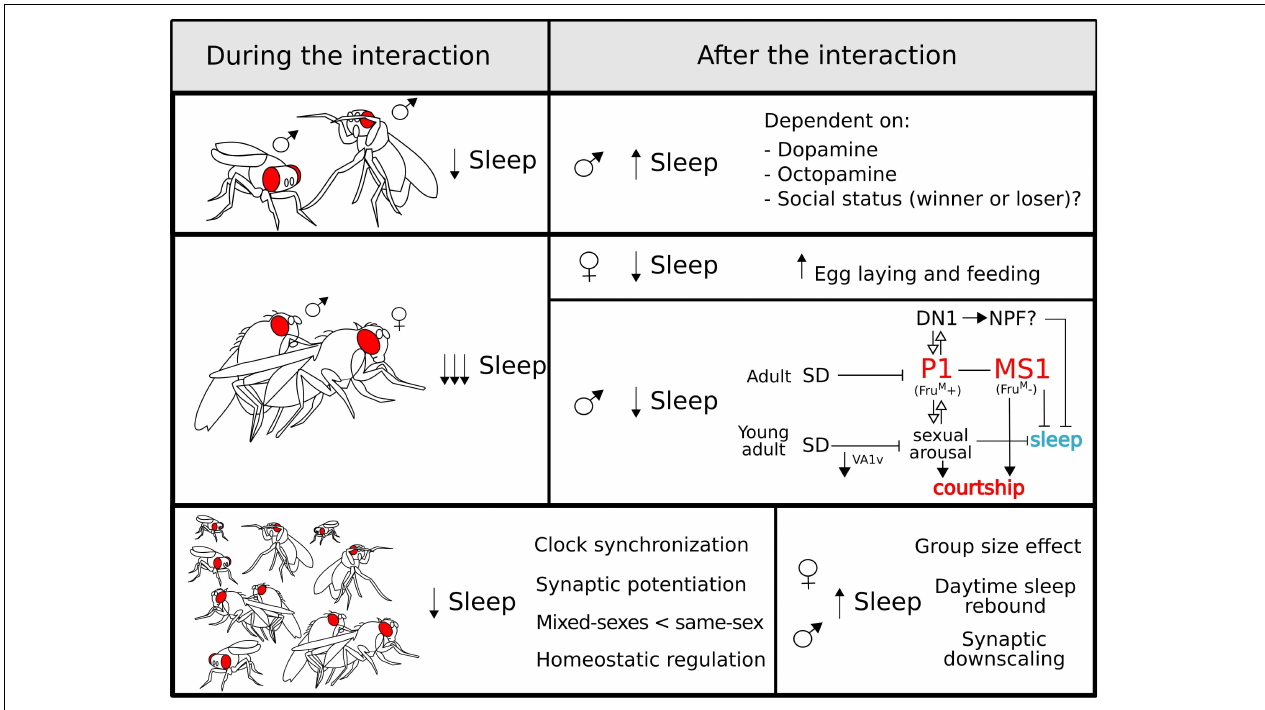
FIGURE 3 | Sleep regulation during (left panel) and after (right panel) different social interactions: sexual (top) , aggressive (middle) , and group (bottom) . During all the interactions, sleep is reduced which is most poignant for sexual encounters. After copulation, males undergo a negative regulation of sleep controlled by sex-drive-related neurons (see the main text for a detailed explanation). For the group interaction (bottom panel) , some characteristics of this type of interaction are highlighted. After a social encounter, the effects on sleep regulation vary depending on the type of interaction and the sex of the